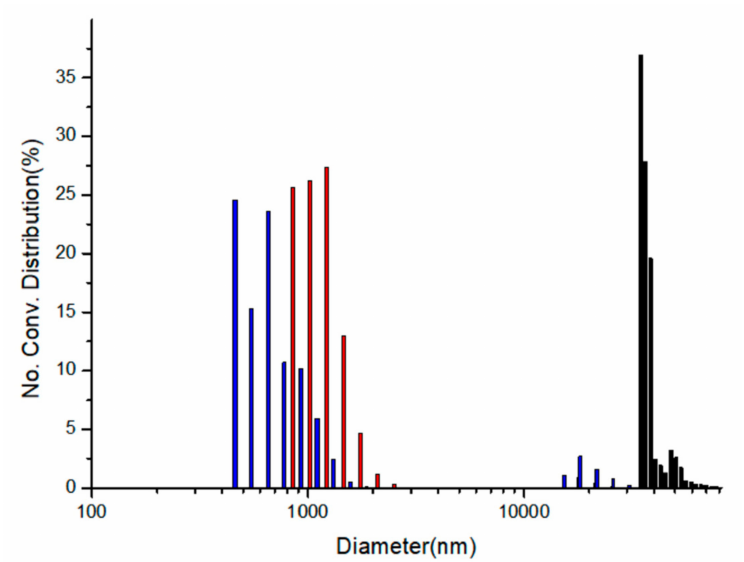
Figure 7. Size distribution diagrams of the colloidal Gly-ZnS:Mn (black), Ala-ZnS:Mn (red), and Val-ZnS:Mn (blue) NPs after addition of 4.0 × 10 − 6 M of Cu(II)